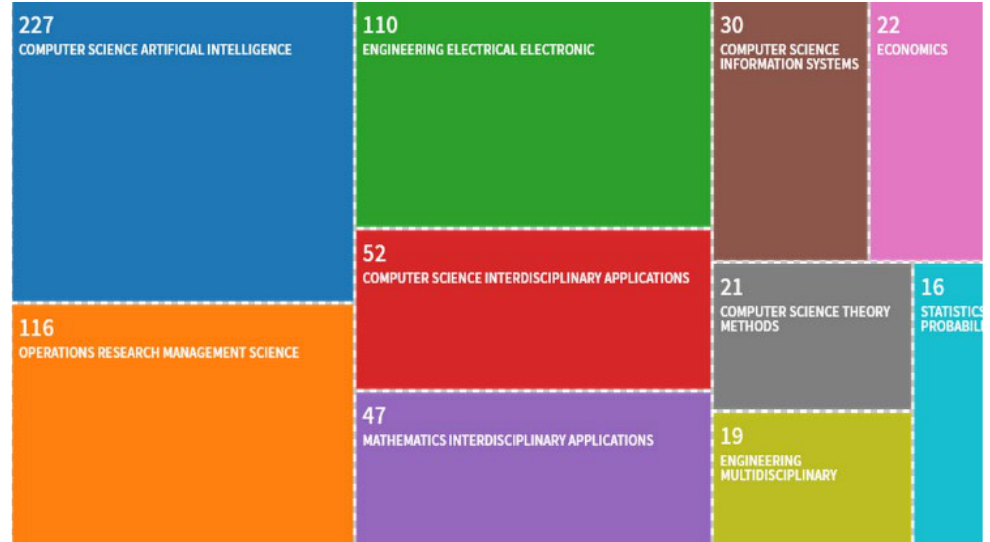
Fig. 5. Subject classification of papers (source: Web of